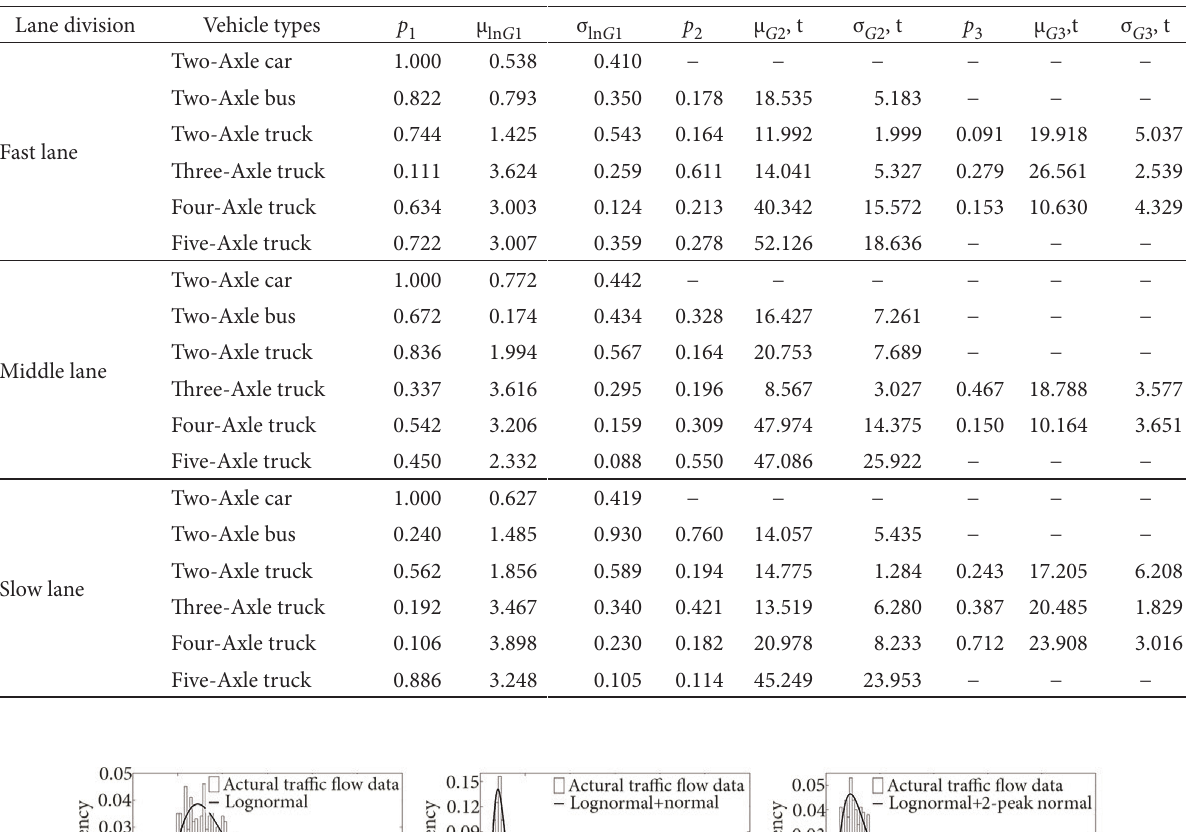
Table 4. Statistical parameters of gross vehicle weight